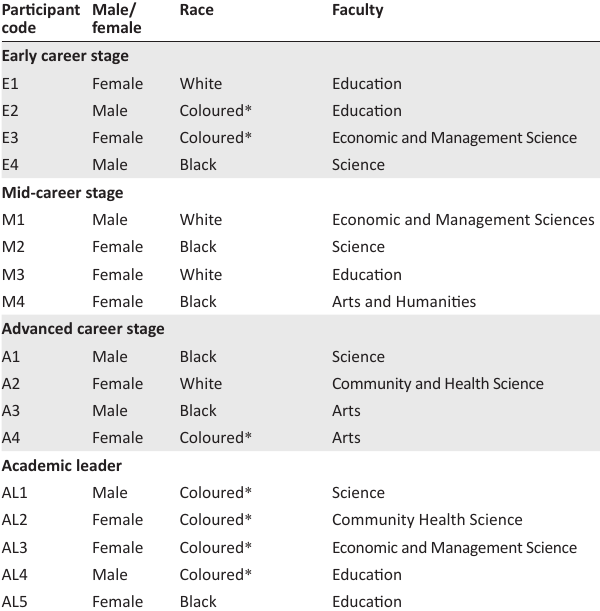
TABLE 1: Participants’ demographic and career